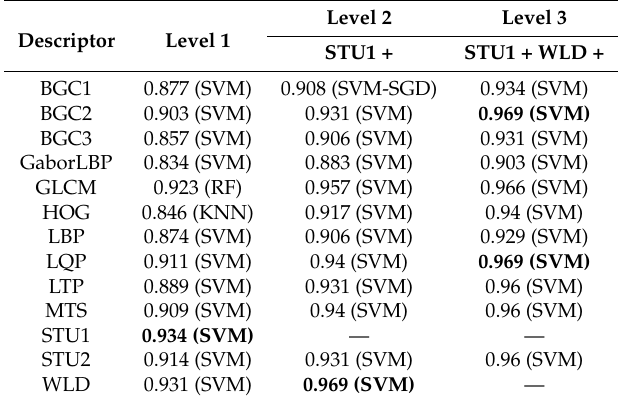
Table 2. Forward Subset Selection of descriptors applied to 4 × 4 gridded image (also known as FSS 4 × 4).